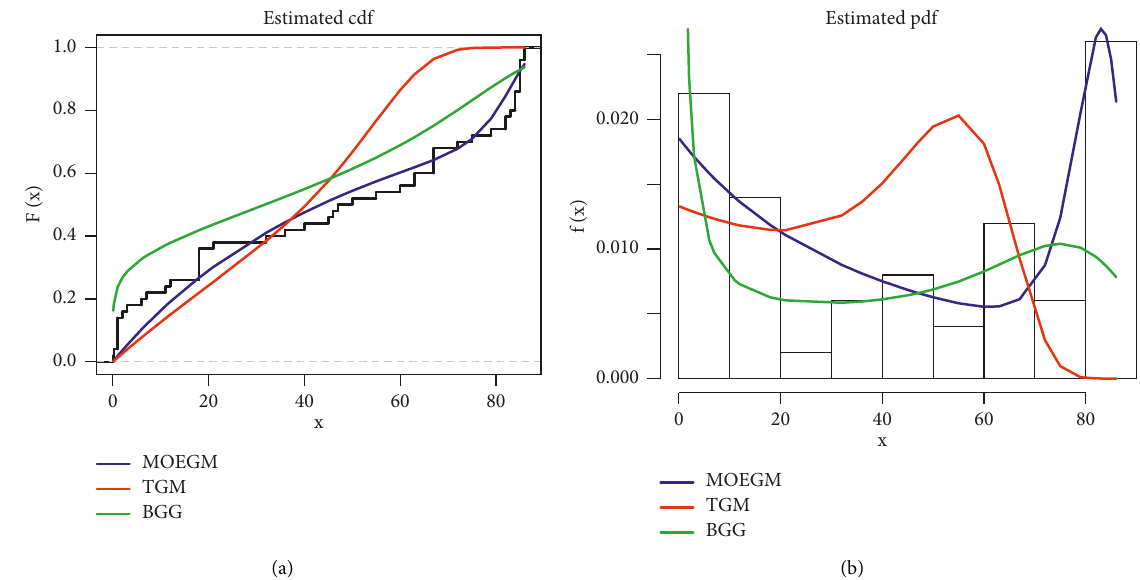
Figure 7: (a) Histogram and estimated p.d.f., (b) Estimated c.d.f. and the empirical c.d.f.: stochastic processes data. Table 7: MLE and Bayesian estimation methods comparing by SE: stochastic processes